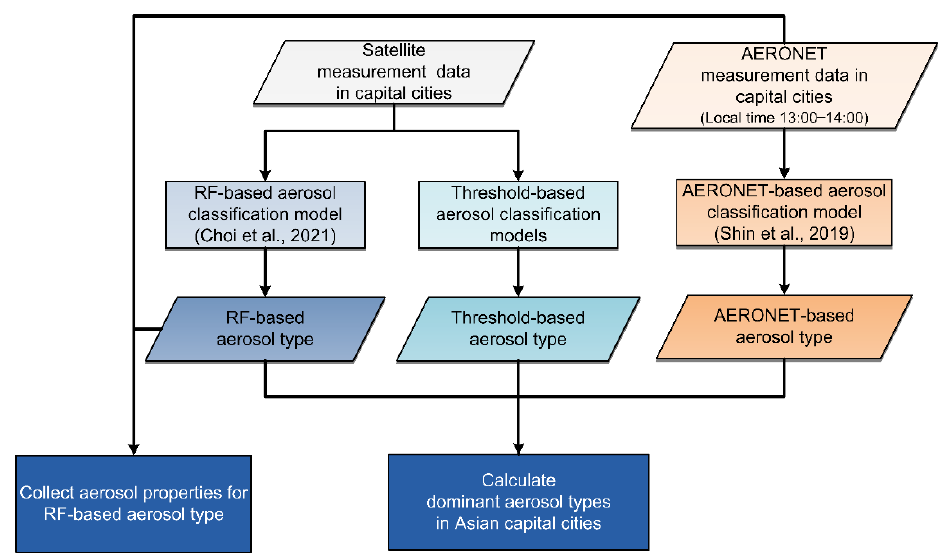
Figure 1. Flow chart of the overall methodology used in this study.